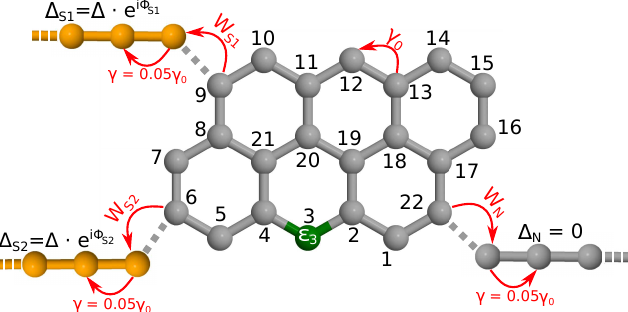
Figure A1. The tight binding model of the Anthanthrene molecule attached to two superconductive and one normal lead. The sites in the molecular core represent p z orbitals of the anthanthrene molecule and are labelled according to the figure. The hopping amplitude between the sites of the molecular core is denoted by γ 0 . The normal (in grey) and superconducting (in yellow) contacts are modeled by one-dimensional conductive channels. The hopping amplitude between the normal (superconducting) lead and the molecular core is given by W N ( W S